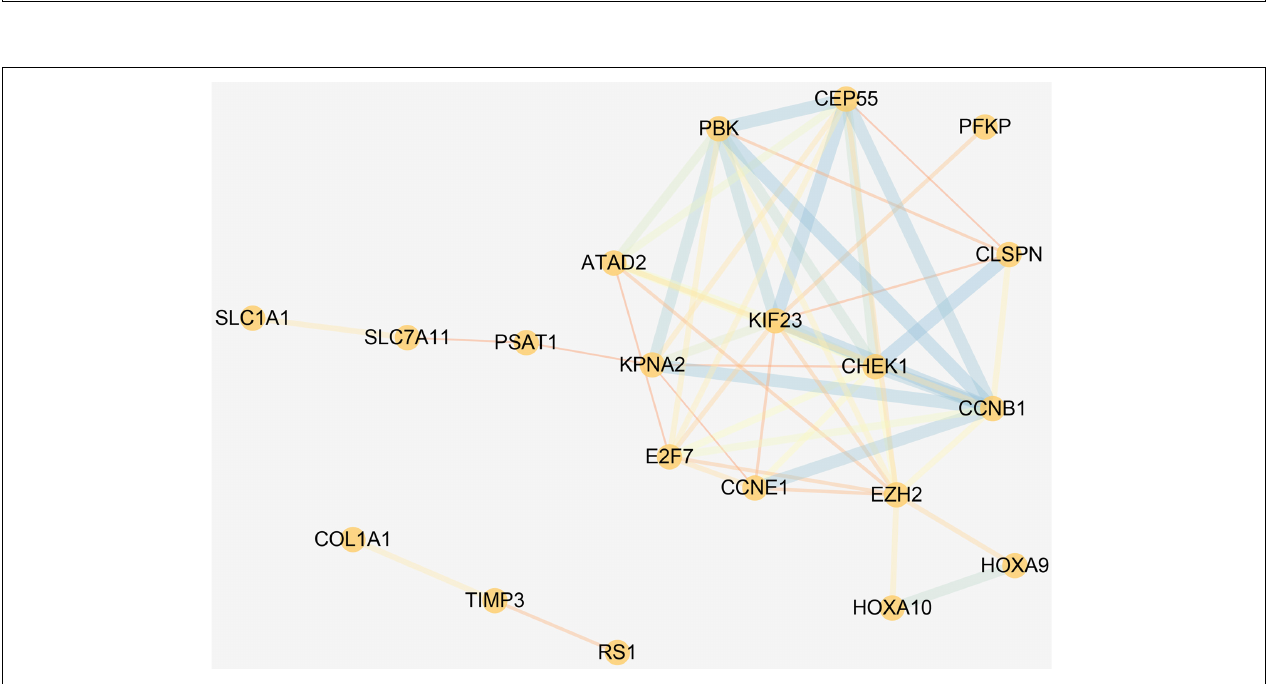
FIGURE 6 | PPI network of the DEmRNAs in the ceRNA network. The circles represent genes, and the lines represent interactions between the proteins encoded by the genes.